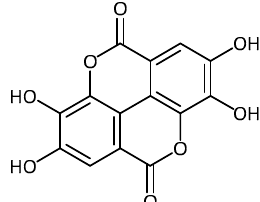
Figure 9. Structure of ellagic acid.